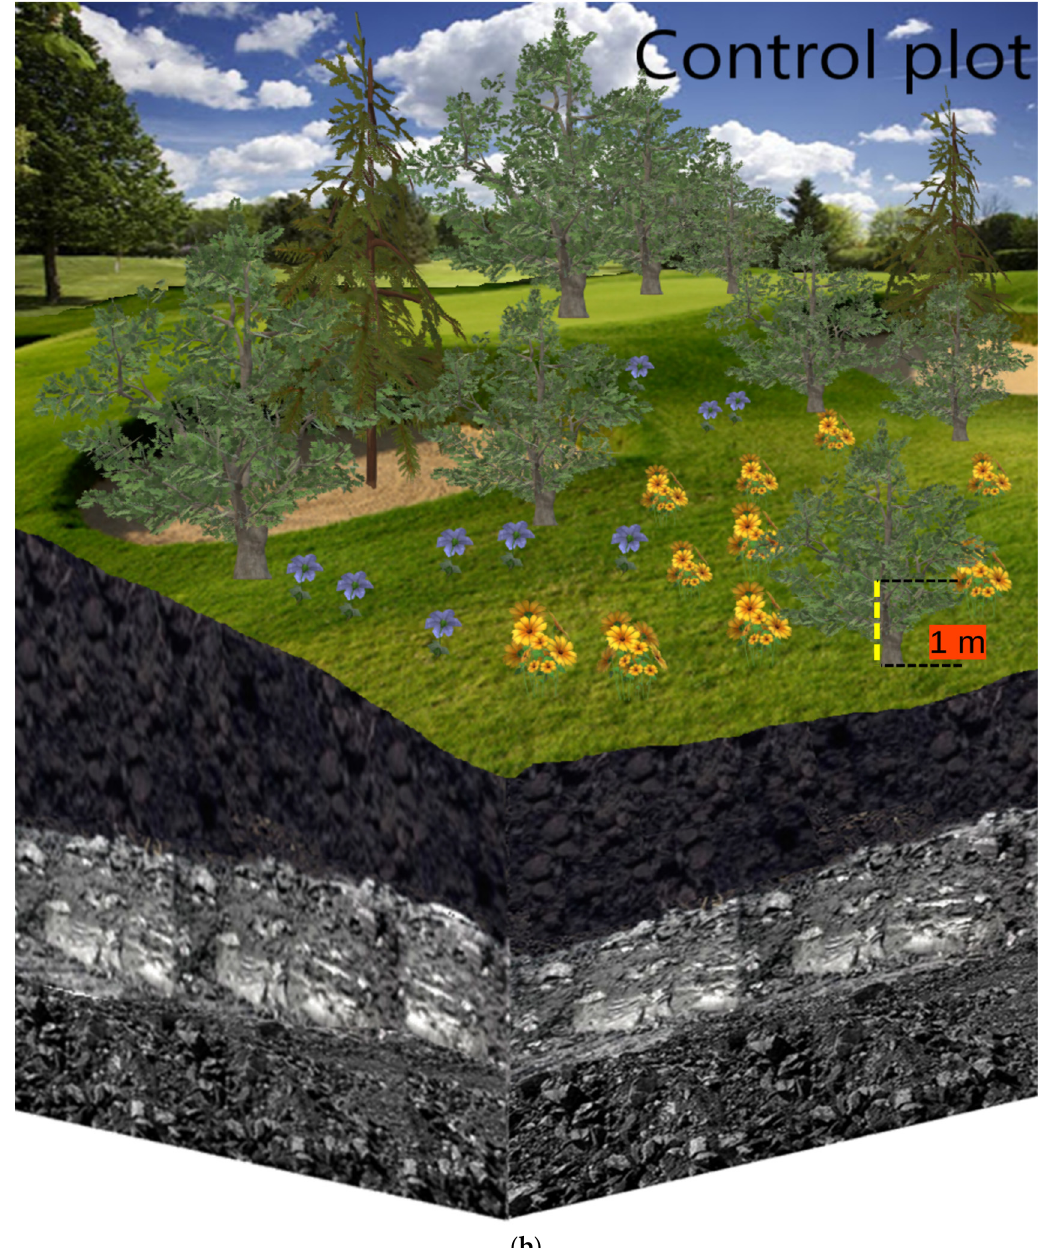
Figure 1. ( a ) Experimental research field located near topsoil heaps in a degraded area. ( b ) Control plot adjacent to the degraded area with spontaneous vegetation.